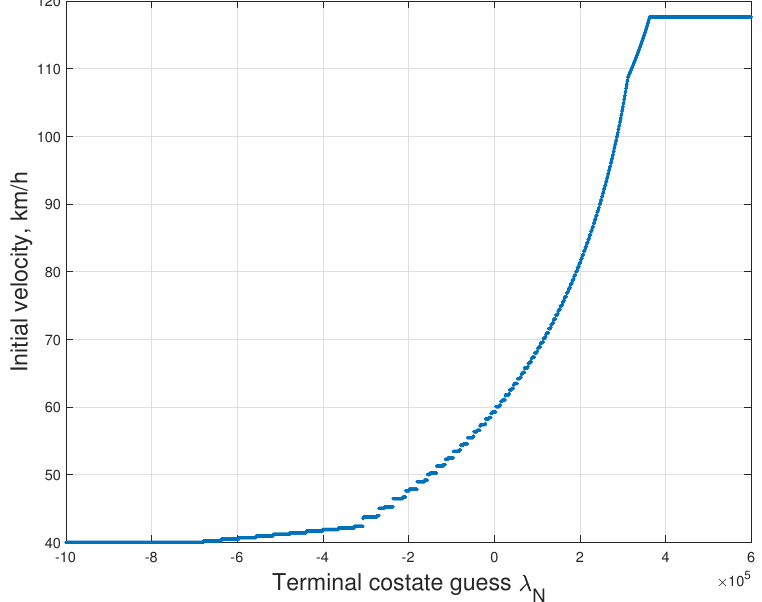
Figure 3. Inital velocity v 0 resulting from different terminal costate λ N with v target = 40 km/h, s f − s 0 = 1500 m and δ s = 10